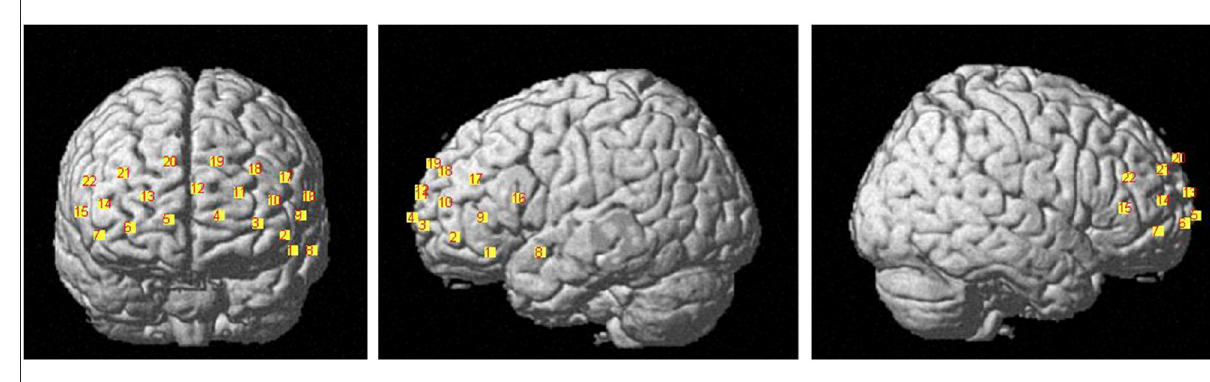
FIGURE1 The locations of 22